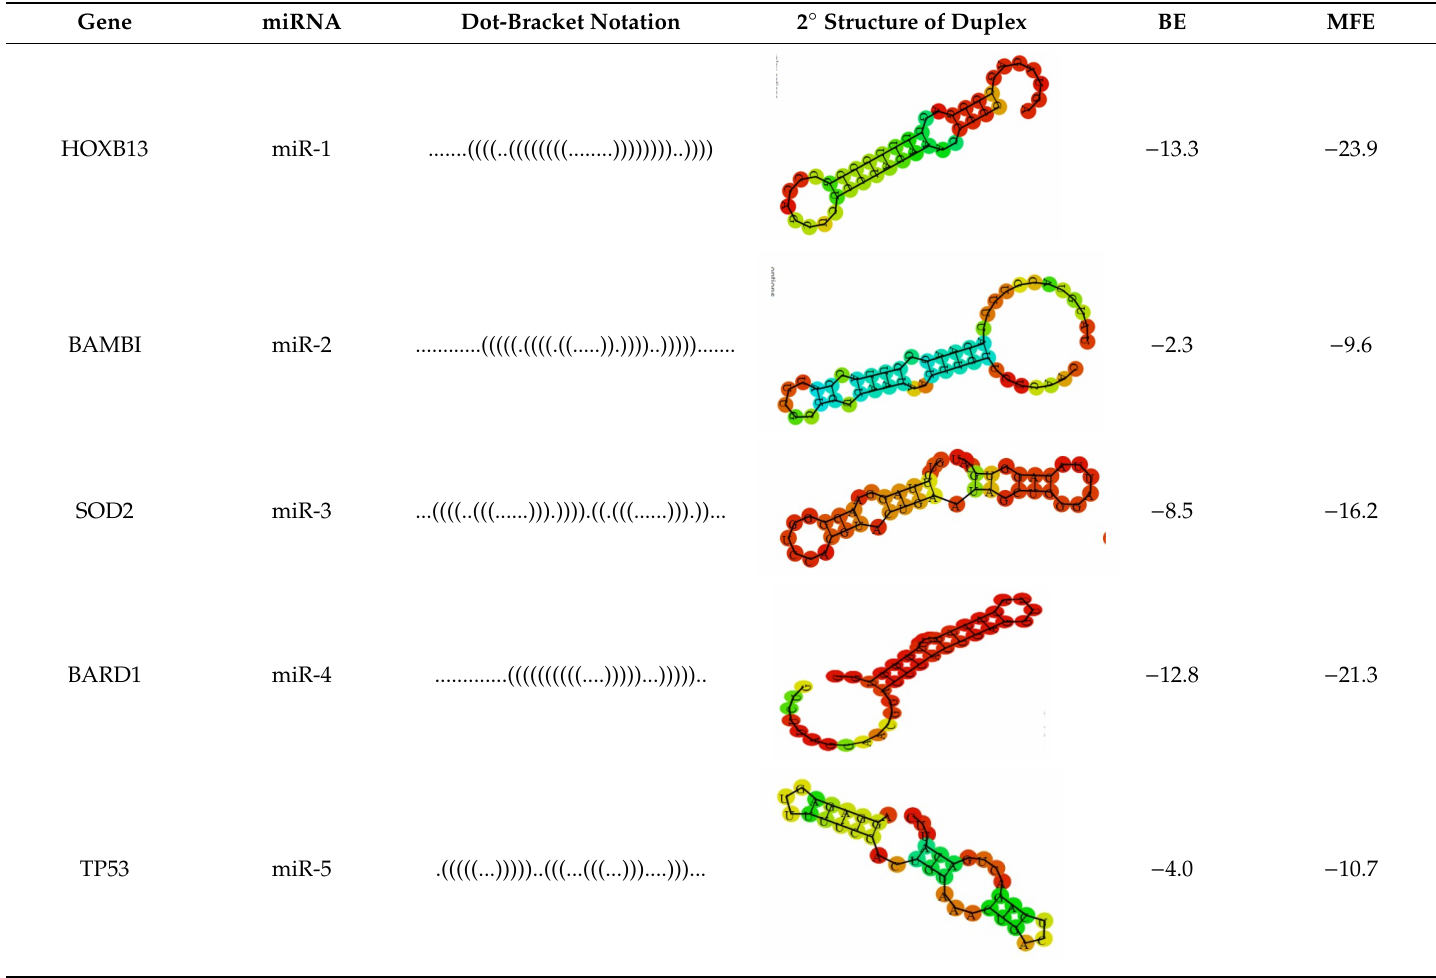
Table 5. Study of binding a ffi nity between miRNA-mRNA